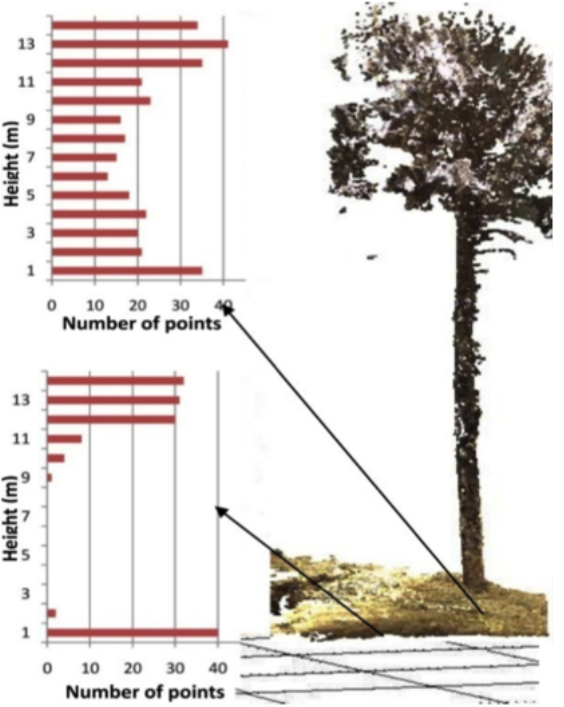
Figure 7. 3D point distribution along the vertical axis to segment out ground